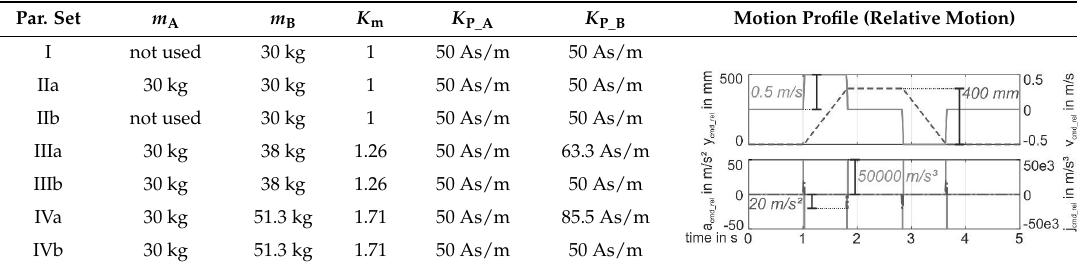
Table 3. Parameter sets (left) and motion profile (right) for the experimental investigation of 1D-KCFC with Axis Control (A) according to Table 2 [11]. Motion Profile (Relative Motion) Par. Set